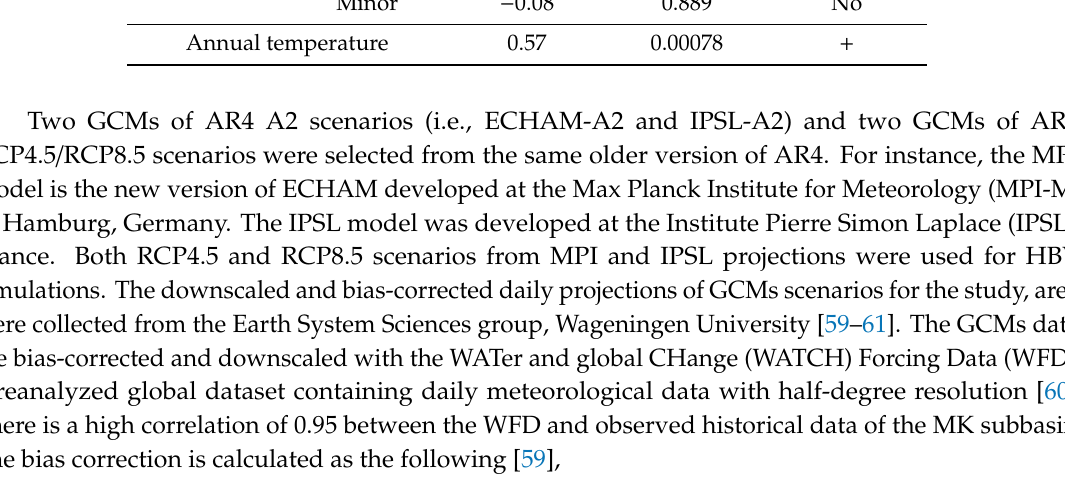
Table 1. Trend test of annual temperature, annual and seasonal rainfall for Melka Kuntrie subbasin. Melka Kuntrie Subbasin Rainfall and Temperature Sen’s Slope p Value Trend Annual 0.11 0.944 No Major 0.14 0.834 No Rainfall Minor − 0.08 0.889 No Annual temperature 0.57 0.00078